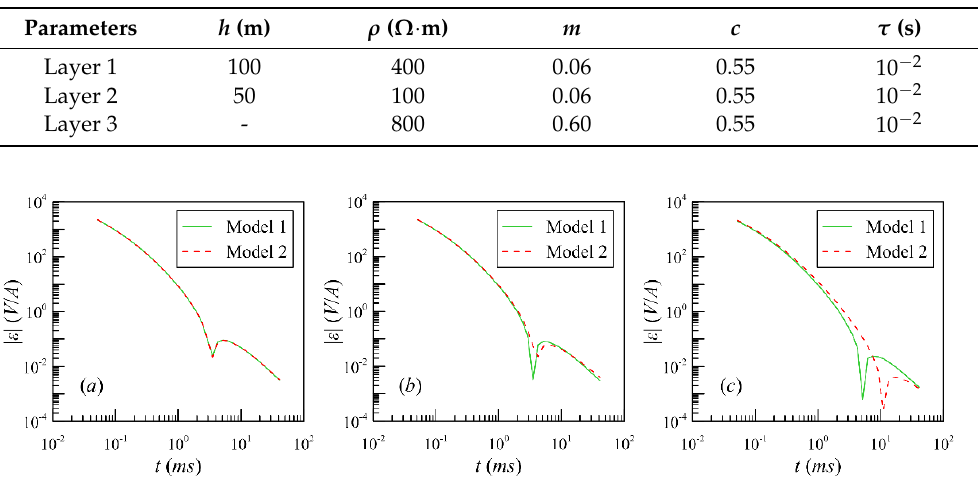
Figure 3. The TEM respones of the equivalent three-layer models. ( a ) The Central loop; ( b ) Offset = 80 m; ( c ) Offset = 120 m. Table 3. Parameters of the equivalent three-layer model (Model